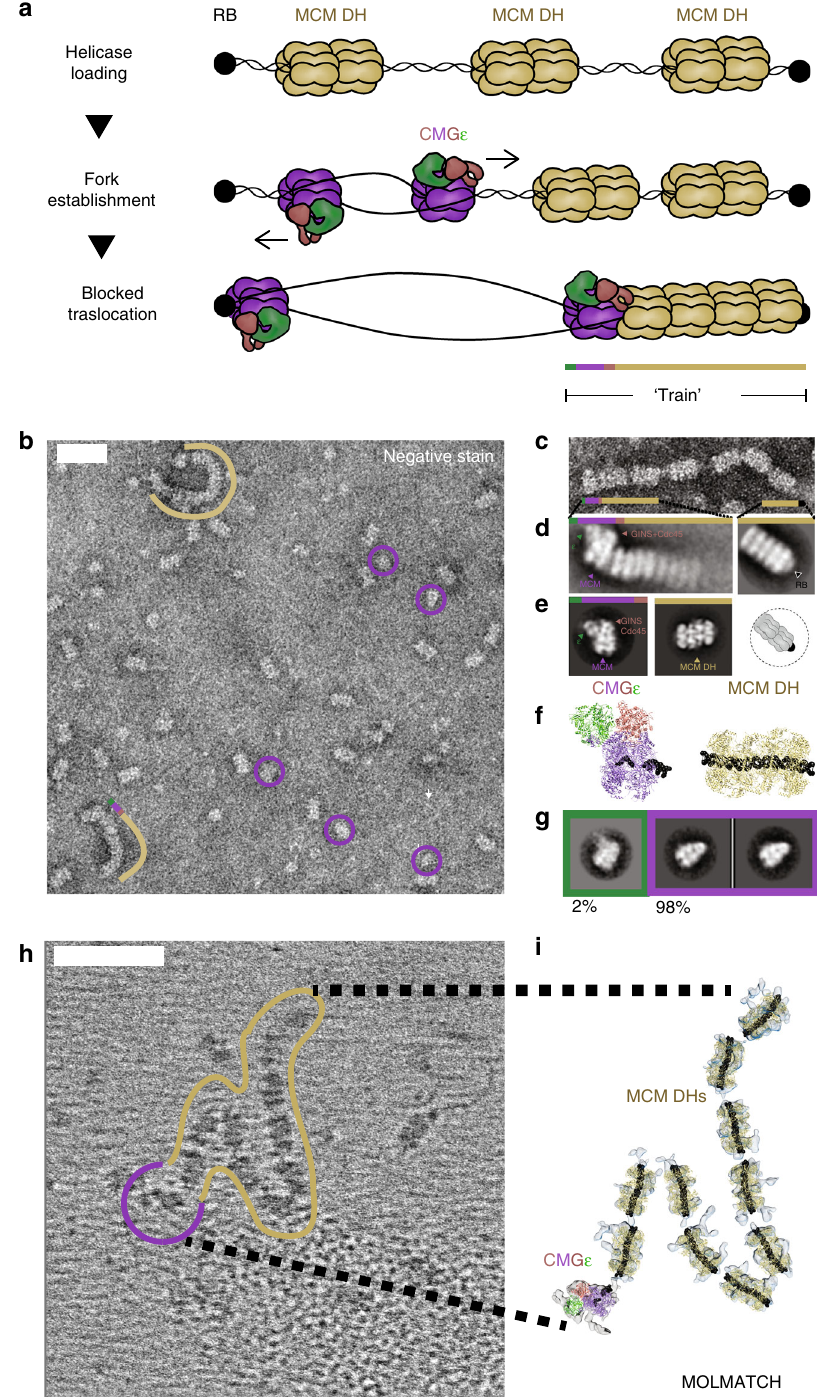
Fig. 7 Composition of the replicative helicase productively engaged to the replication fork. a Diagram of the EM-based translocation assay. Multiple MCM double hexamers are loaded onto a linear stretch of duplex DNA capped with protein – DNA roadblocks. Only certain MCM double hexamers are activated and translocating CMGs push MCM double hexamers against the DNA roadblock. b Representative negative-stain micrograph reveals accumulation of MCM trains (marked with a khaki line) alongside isolated CMGs (marked with purple circles). Scale bar 50 nm. c Detail of a negative-stain micrograph revealing that MCM trains are made of stacked double hexamers loaded onto DNA. d Two-dimensional averages of the CMG capping the trains and opposed end of trains capped by a protein roadblock. Most MCM-pushing CMG particles are bound to Pol epsilon. e 2D averages of CMG-Pol epsilon and MCM double hexamers, next to a cartoon of an MCM blocked by a protein – DNA roadblock. f Atomic structures of CMG-Pol epsilon and MCM double hexamer, both bound to DNA. g 2D class averages of isolated CMGs observed in the MCM train experiment. Most CMGs that failed to translocate up to the roadblock are not engaged by Pol epsilon. h Cryo-electron tomogram of an MCM train. Scale bar 50 nm. i MCM and CMG structures placed into the cryo-electron tomogram using template matching approaches. This experiment supports the notion that CMG-Pol epsilon particles push MCM double hexamers against a protein – DNA roadblock to form MCM